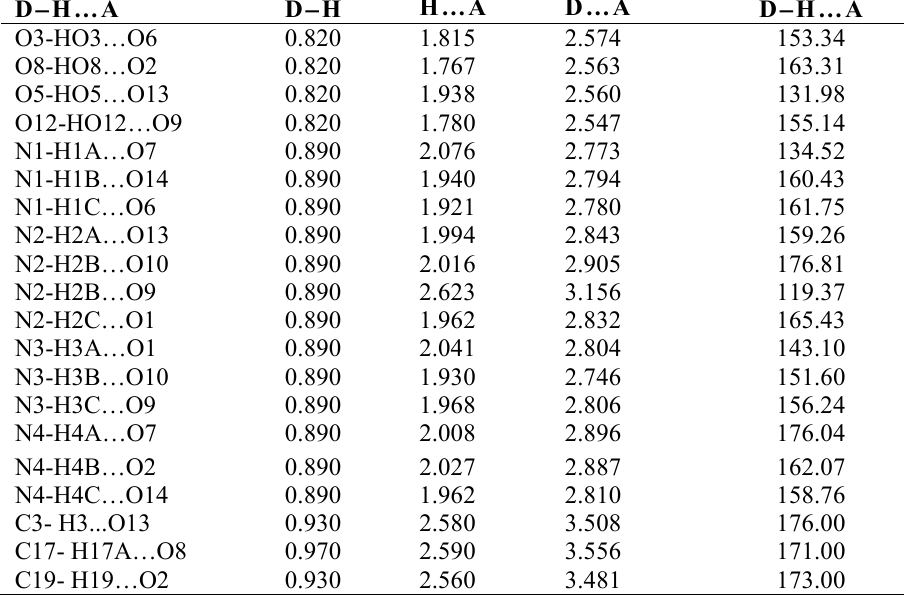
Table 2. Main interatomic distances (Å) and angles (°) involved in the hydrogen